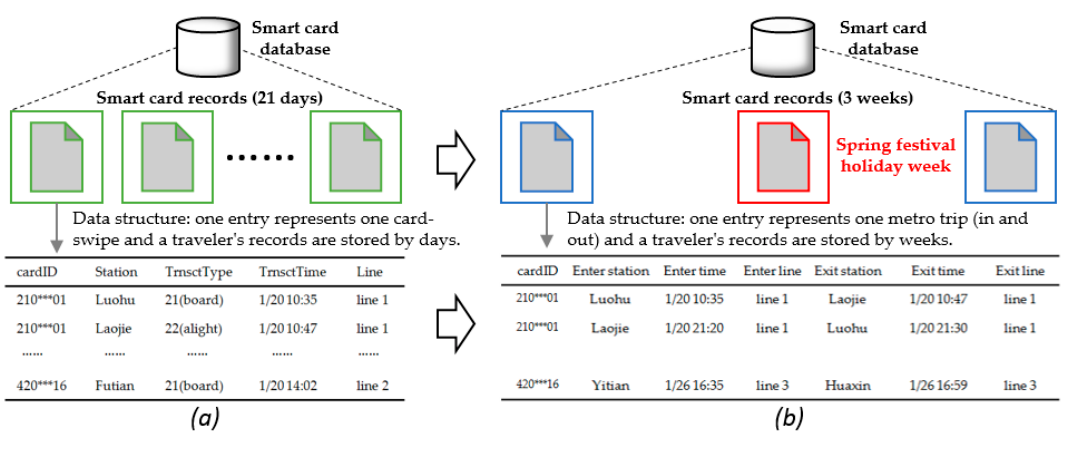
Figure 3. Examples of the smart card data reconstruction. ( a ) original data storage form; ( b ) reconstruction of the data storage format.